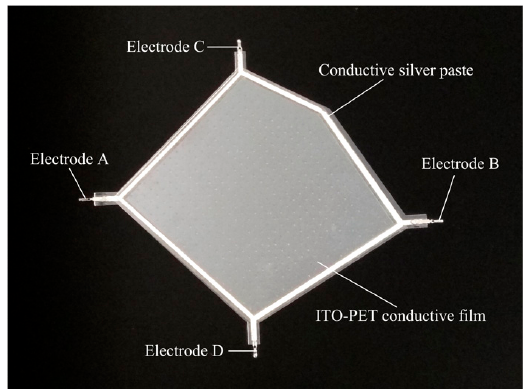
Figure 13. Process of fabricating the sensor.